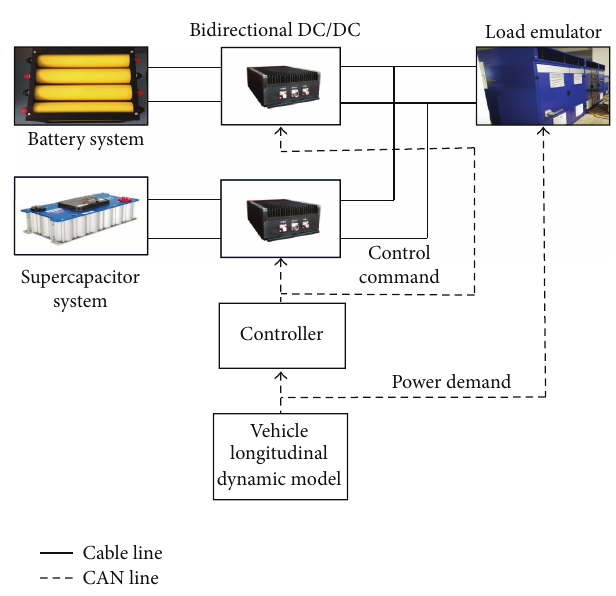
Figure 5: A fully active topological